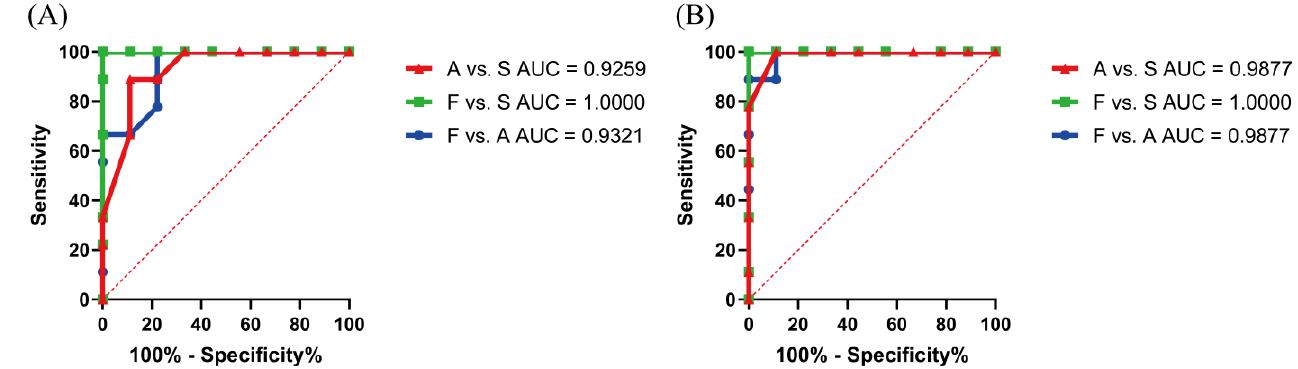
Figure 7. The ROC curve of peptide MVHMASKE in pork under storage at 4 °C ( A ) and 25 °C ( B ). F, fresh state; A, accelerated spoiled state; S, spoiled state.